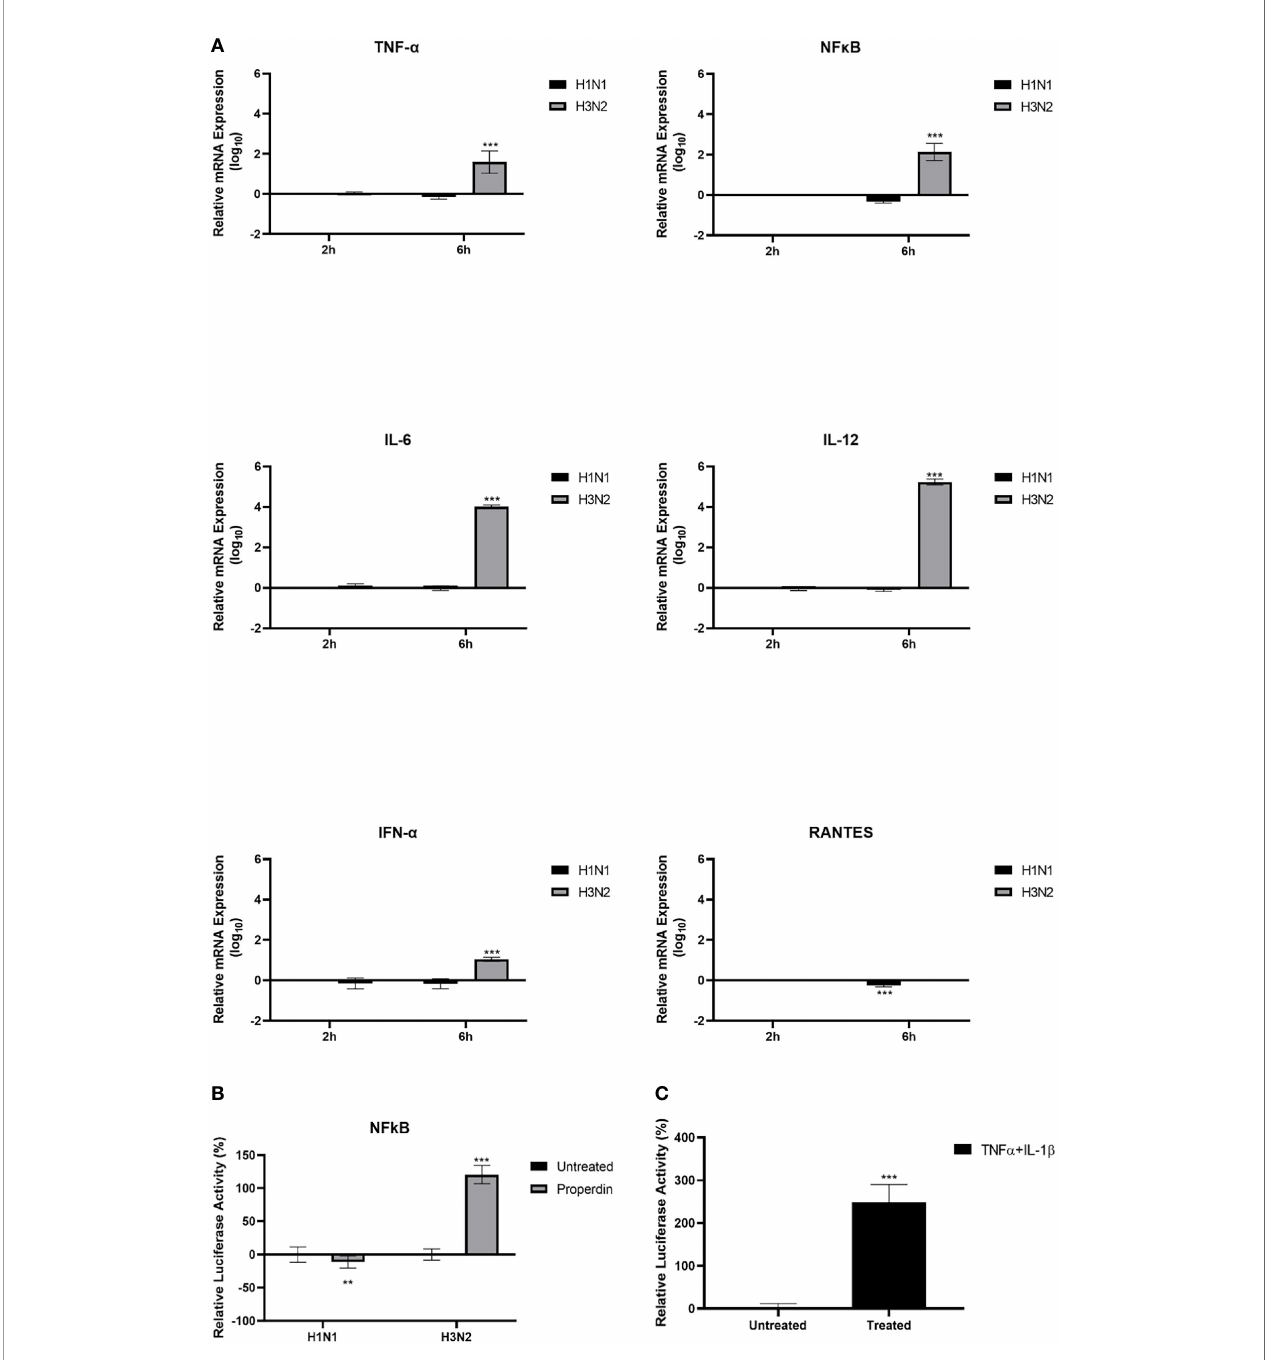
FIGURE 6 | Properdin triggers an anti-in fl ammatory response in H1N1-infected A549 cells while provoking a pro-in fl ammatory response in the case of H3N2 infection. mRNA expression levels of selected cytokines and chemokines (TNF- a , IL-12, IL-6, RANTES, IFN- a and NF- k B) were measured using qRT-PCR using the primers listed in Table 2 . (A) The data were normalised via 18S rRNA expression as an endogenous control. The relative expression (RQ) was calculated using the untreated sample (cells + virus only) as the calibrator. The RQ value was calculated using the formula: RQ = 2 − DD Ct. NF- k B activation was measured via luciferase reporter assay in these cells following challenge with properdin treated H1N1 or H3N2 subtypes (B) . The relative NF- k B activity was calculated using the untreated sample (cells + virus only) as the baseline. A549 cells treated with TNF- a and IL- b was used as a positive control for NF- k B activation (C) . Assays were conducted in triplicates, and error bars represent ± SEM. Signi fi cance was determined using the two-way ANOVA test (**p < 0.01 and ***p < 0.001) (n =